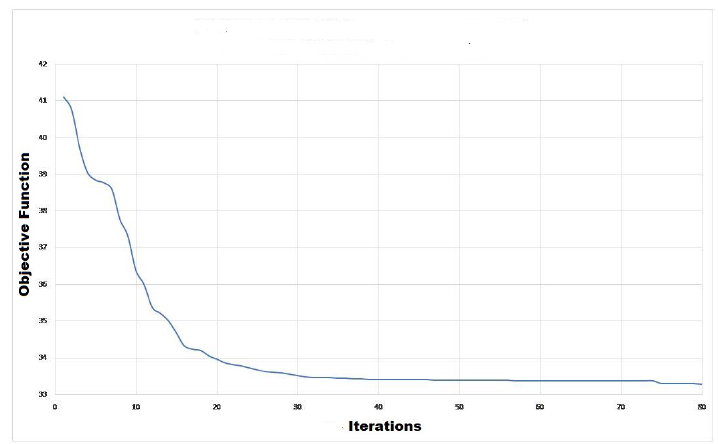
Figure 7. Objective function system II.